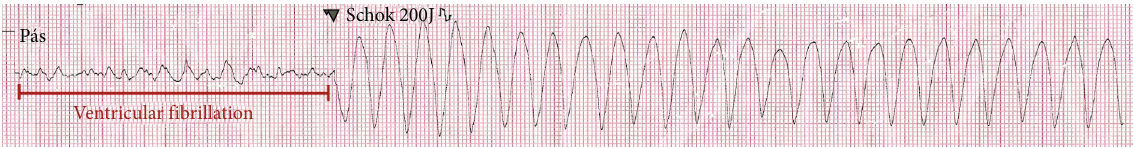
Figure 1: Twelve-lead electrocardiogram showing ventricular fi brillation. A biphasic shock of 200 J was applied with conversion to a regular wide complex tachycardia with a heart rate of